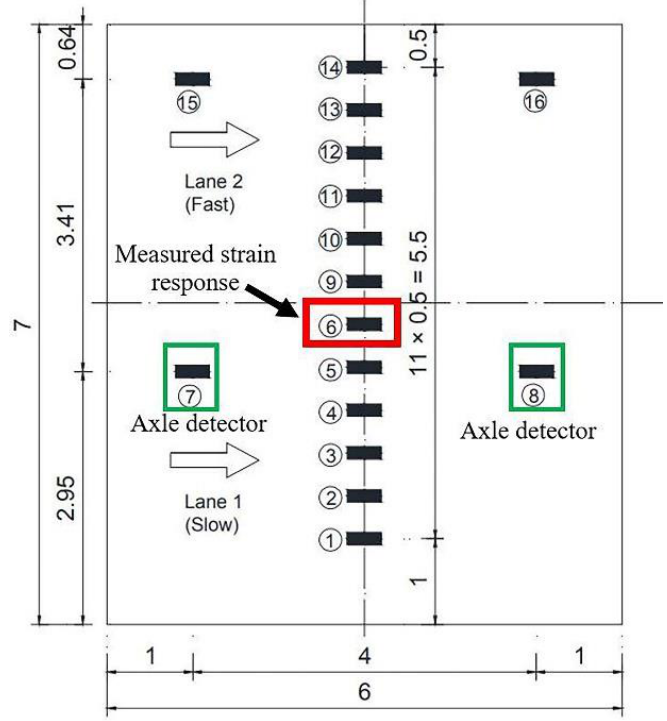
Figure 12. Plan layout of the transducers on the Šentvid bridge (dimensions in m). The acceleration-based BWIM can be applied to accelerometers or existing strain-based systems. Strain-based WIM (SiWIM) [43] is more common as the accelerometer WIM is still in early development. For the field tests, one year of data of passing trucks with axle-weights calculated from the SiWIM system is used. The mid-span strain responses of the bridge are used to approximate the acceleration responses as the di ff erence of strain di ff erences. It should be noted that these derived accelerations are oriented horizontally (longitudinally) rather than vertically, as would normally be measured using an accelerometer. For the remainder of the paper, acceleration response means derived accelerations from the SiWIM.